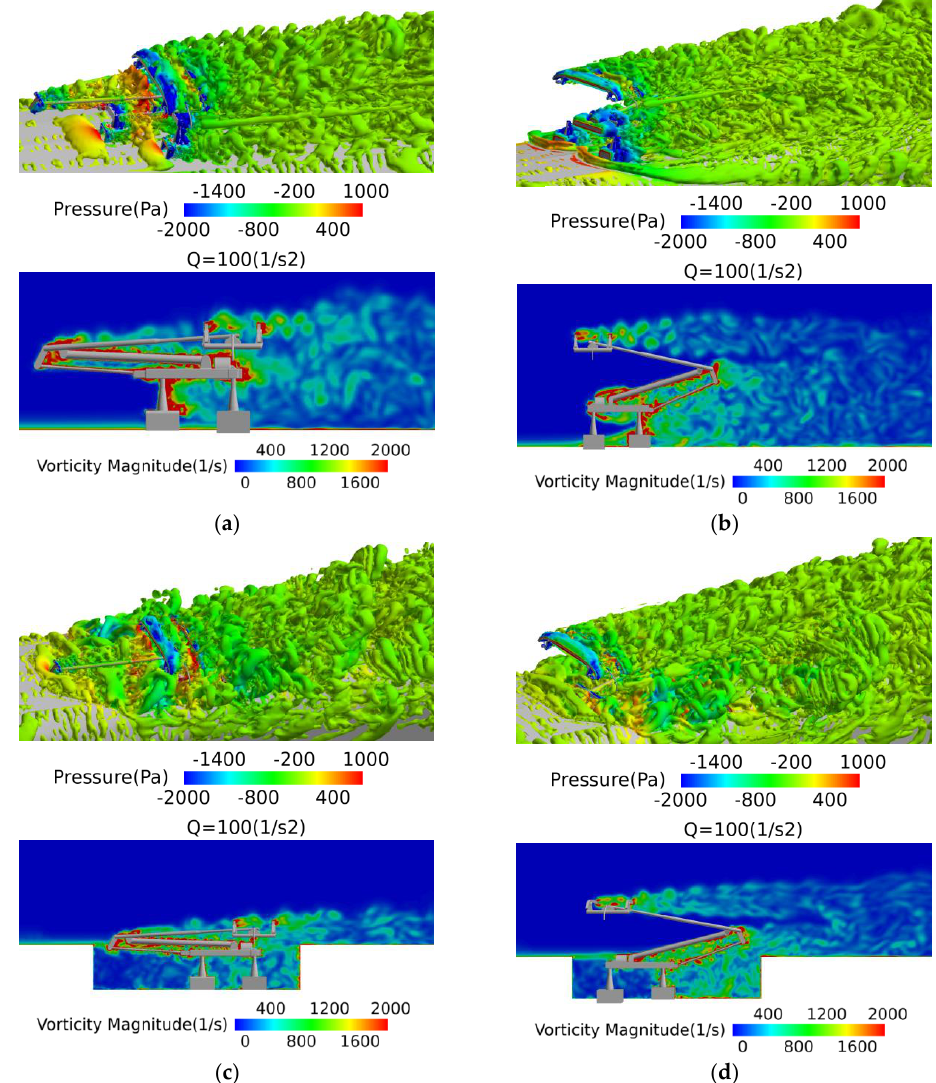
Figure 13. Instantaneous iso-surface normalized Q-criterion (Q = 100/s 2 ) and vorticity magnitude(1/s) on: ( a ) down-pantograph with flush base; ( b ) up-pantograph with flush base; ( c ) down-pantograph with sunken base; and ( d ) up-pantograph with sunken base.